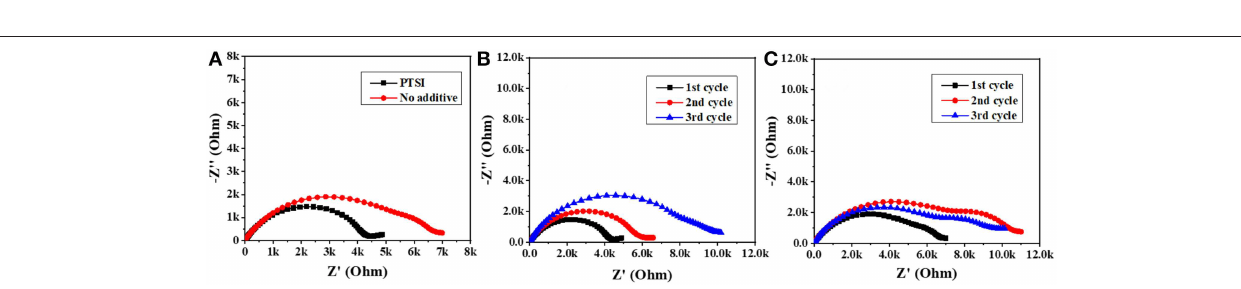
FIGURE 1 | (A,B) Cycling performance of LNMO/Li cells at different cycles with no additive and with 0.5 wt.% PTSI additive in a voltage range of 3.0–4.98V; (C) Coulombic efficiency of LNMO/Li cells with no additive and with 0.5 wt.% PTSI.